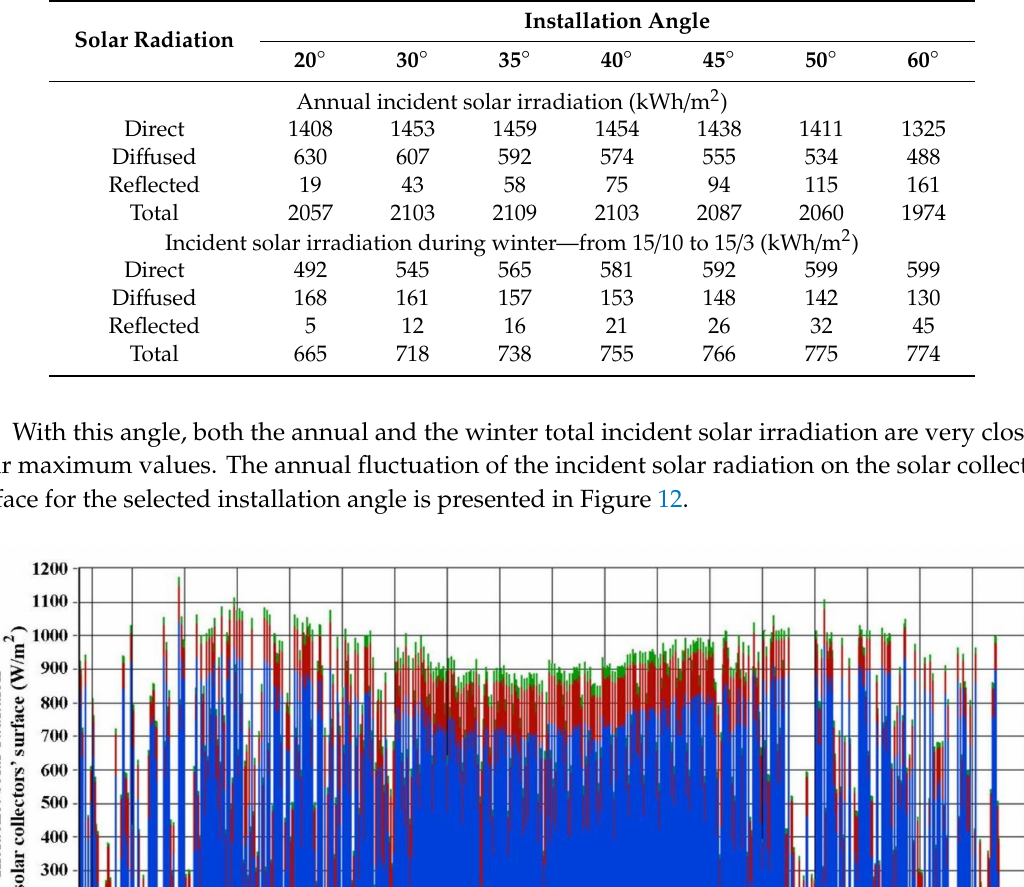
Table 5. Variation of the incident solar irradiation on the solar collectors’ surface, versus their installation angle.